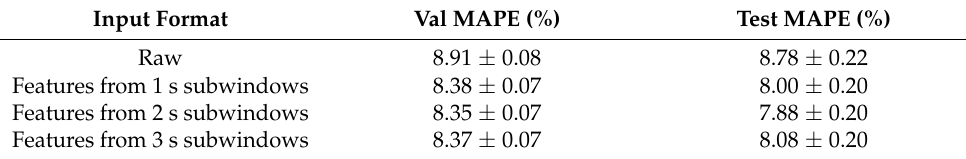
Table 5. Results of regression task using different input format and user